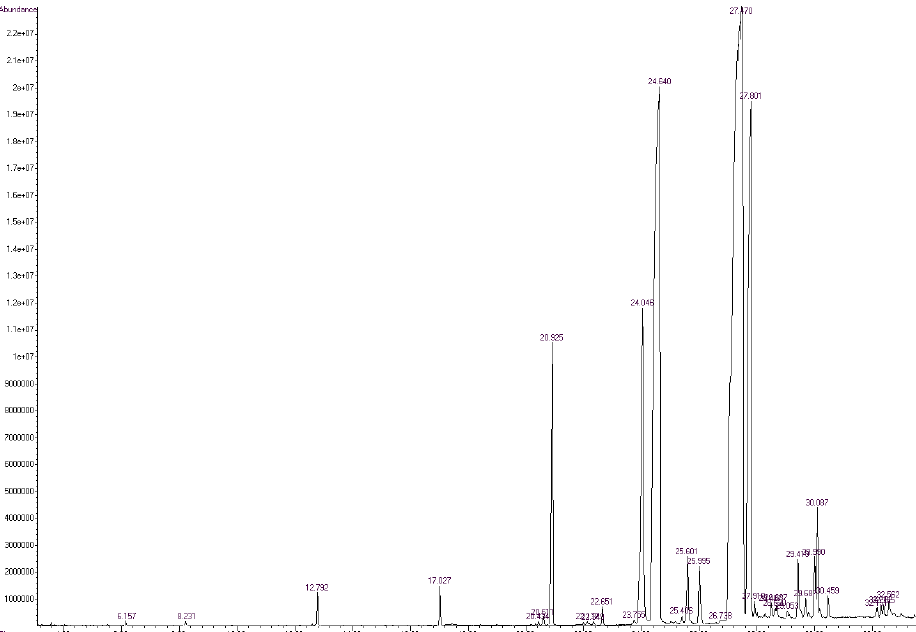
Figure 3. Gas chromatogram from the GC-MS analysis of the derivatized layer 1 of Mangalitza hard fat (raw sample, code U1). All other GC chromatograms for the raw samples are presented in the Supplementary material file (Figures S1, S3, S4, S7, and S8).